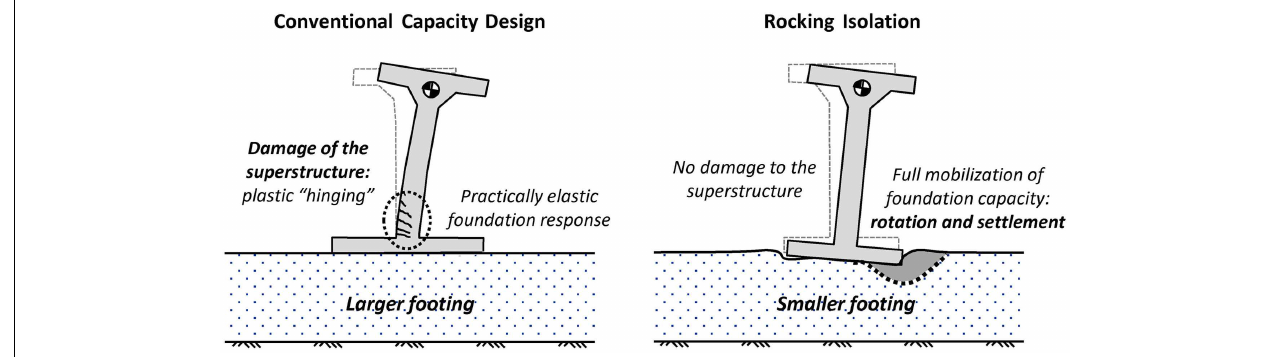
FIGURE 1 | Conventional capacity design vs. rocking isolation . While in the first case the plastic hinge develops in the superstructure, in a rocking-isolated system the foundation capacity is fully mobilized to protect the superstructure, at the cost of foundation rotation and